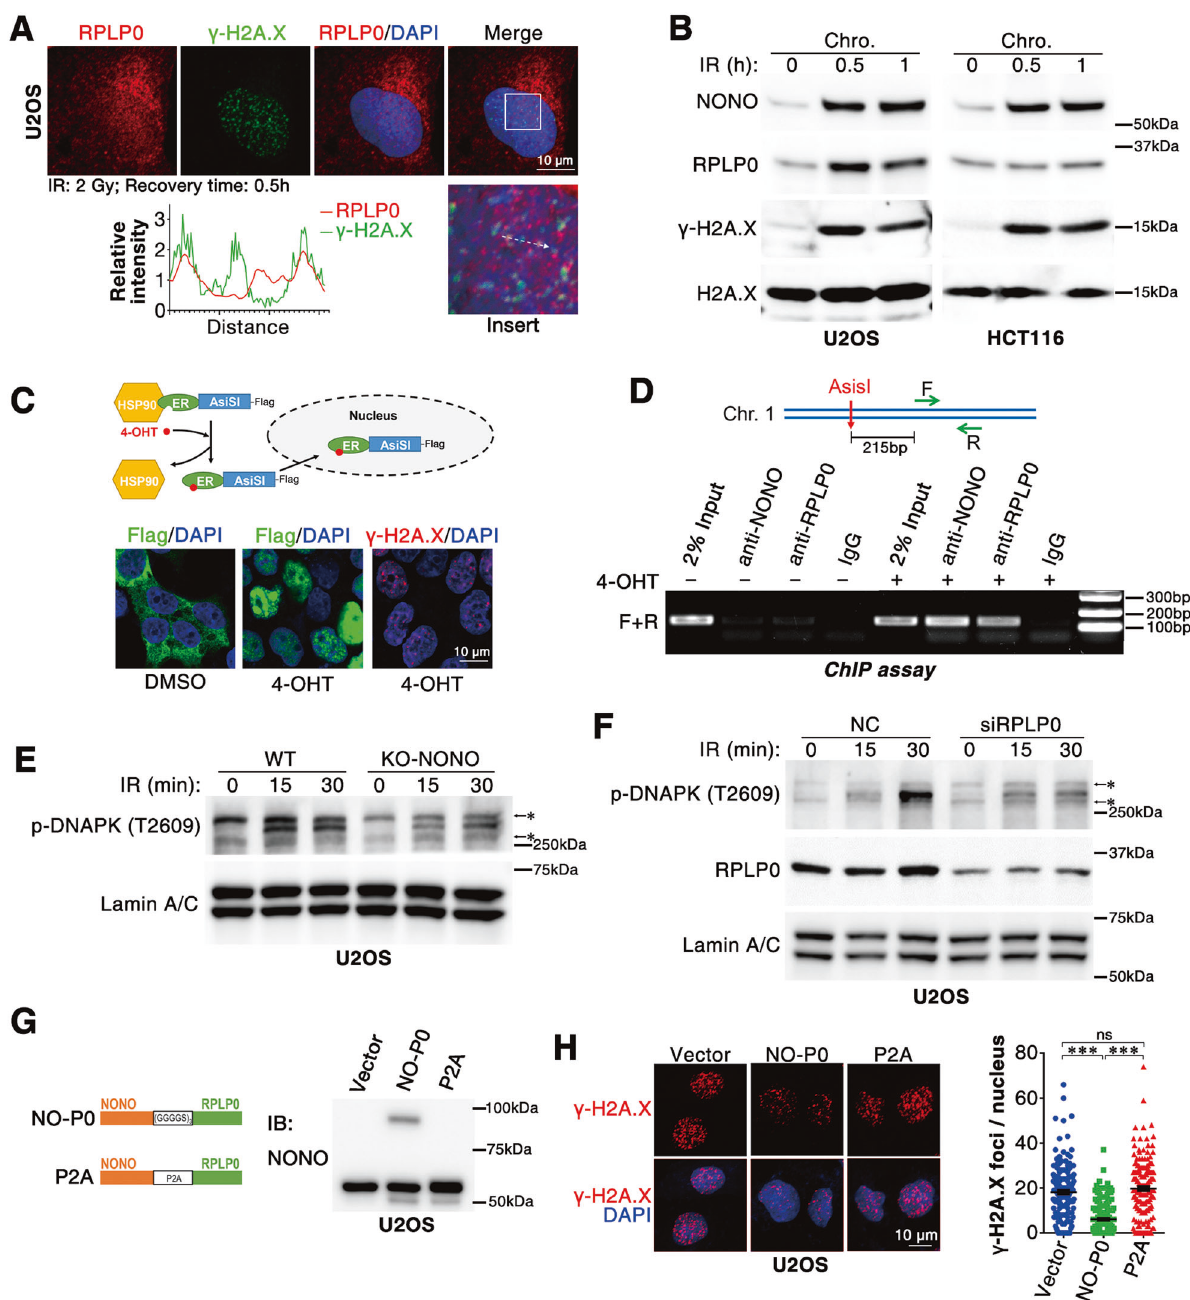
Fig. 5 NONO and RPLP0 bind to damaged DNA and increase the phosphorylation of DNA-PK at pT2609. A RPLP0 colocalizes with γ -H2A.X after irradiation. U2OS cells were irradiated (2 Gy) and cultured for 30 min before analysis. Scale bars, 10 μ m. B NONO and RPLP0 load into chromosome upon DNA damage. Twelve hours after seeding, cells were treated with radiation (10 Gy) and cultured for indicated time before chromosome fractionation. C 4-OHT induces DNA damage by facilitating the nuclear import of endonuclease ER-AsiSI. Cells were treated with 300 nM 4-OHT for 4 h before IF assay. Scale bars, 10 μ m. D The binding of NONO and RPLP0 to damaged DNA was examined with ChIP assay. Four hours after 4-OHT or DMSO treatment, ER-AsiSI-expressing U2OS cells were analyzed with ChIP assay. E , F NONO depletion or RPLP0 silencing inhibits the phosphorylation of DNA-PK at T2609. U2OS cells were irradiated (10 Gy) and cultured for indicated time before nuclei isolation, which were further analyzed by western blotting. *, unspeci fi c band. G The construction of NONO-RPLP0 fusion protein. (GGGGS) 3 , triplication of GGGGS; P2A, GSGATNFSLLKQAGDVEENPGP. H NONO-RPLP0 fusion protein promotes DNA repair. n (Vector) = 178 nuclei, n (NO-P0) = 199 nuclei, n (P2A) = 179 nuclei. Scale bars, 10 μ m. ***; P < 0.001; ns no signi fi cance.